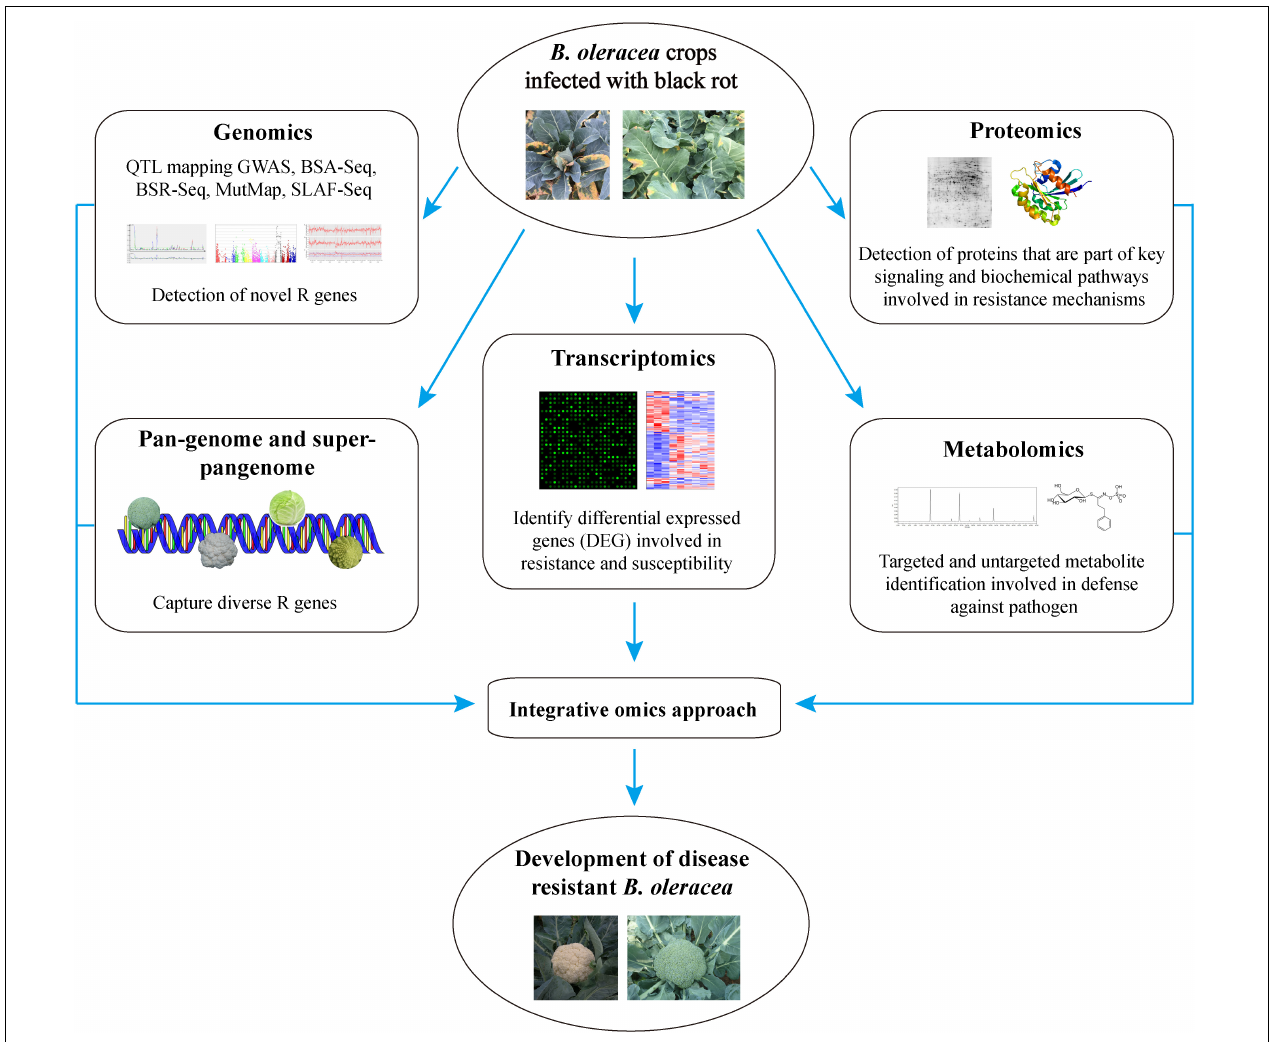
FIGURE 1 | The application of ‘multi-omics’ technologies to develop Xcc resistant B. oleracea and to understand the mechanisms of disease